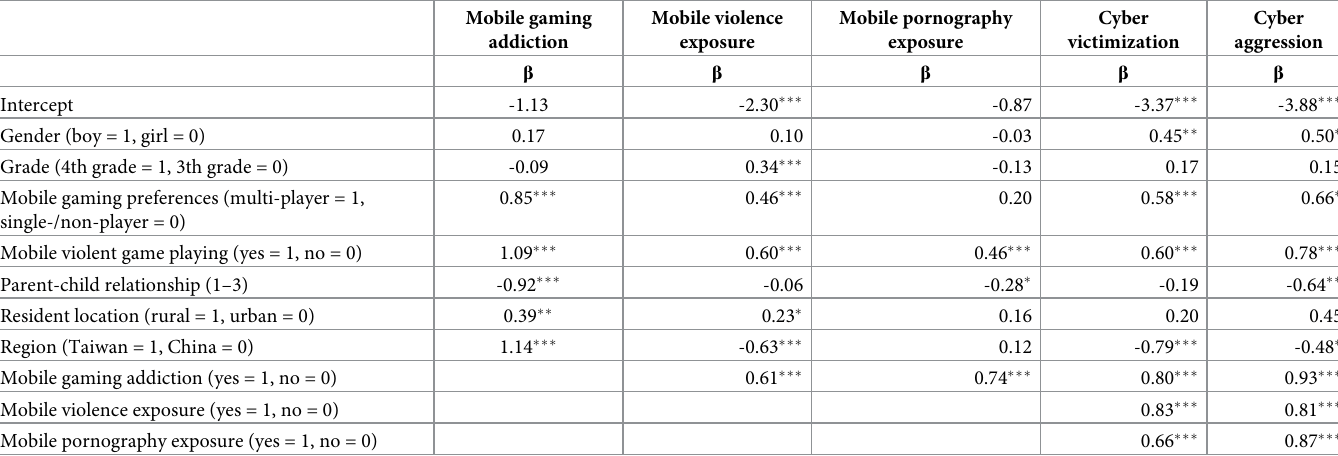
Table 5. Factors related to children’s online